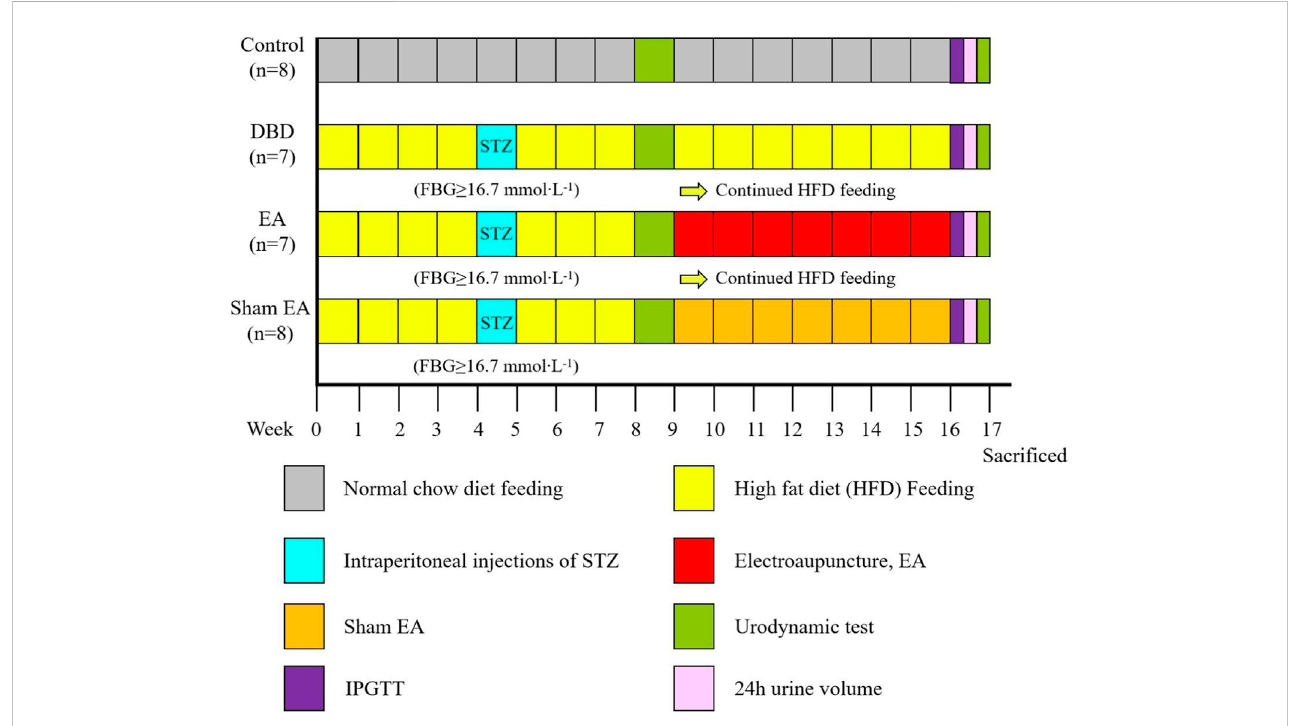
FIGURE 1 Time fl ow chart of rat modeling and experimental intervention. Timeline for modeling and intervention